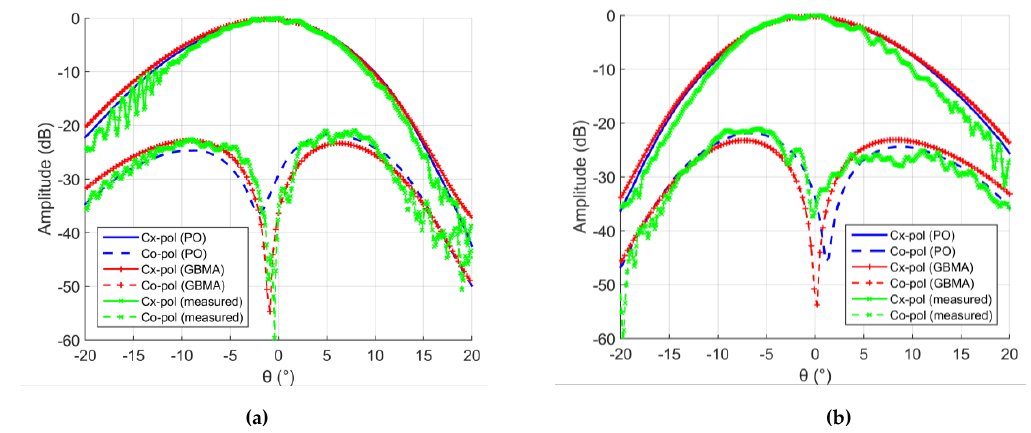
Electronics 2021 , 10 , x FOR PEER REVIEW